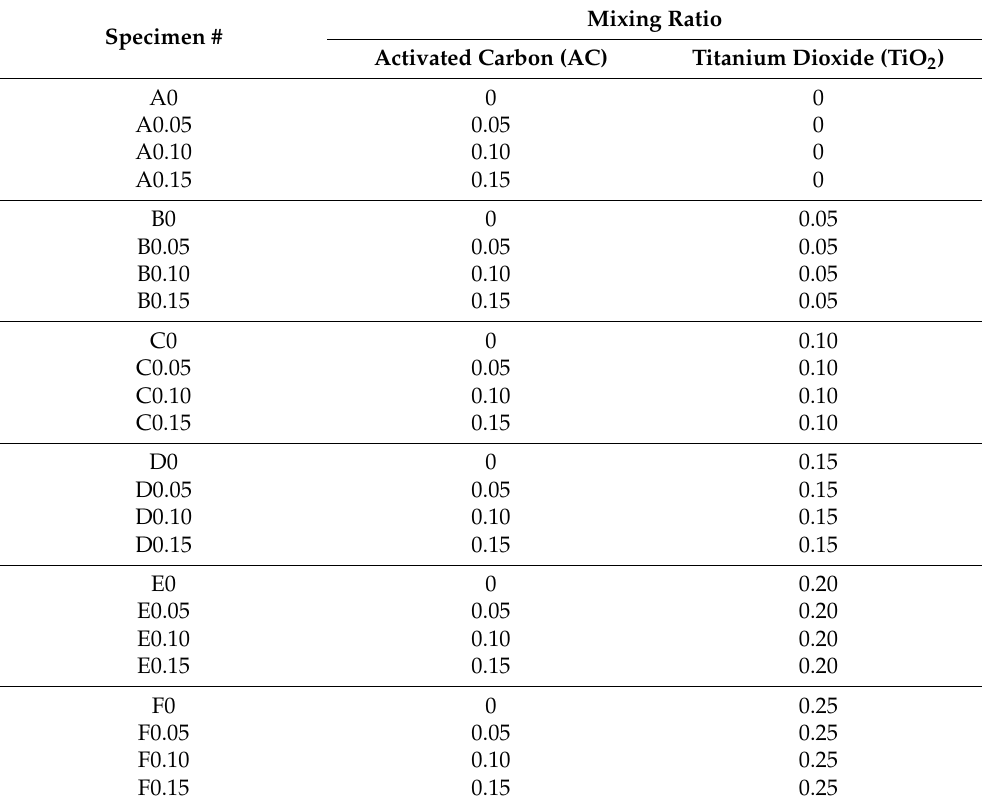
Table 1. Test cases for algorithm